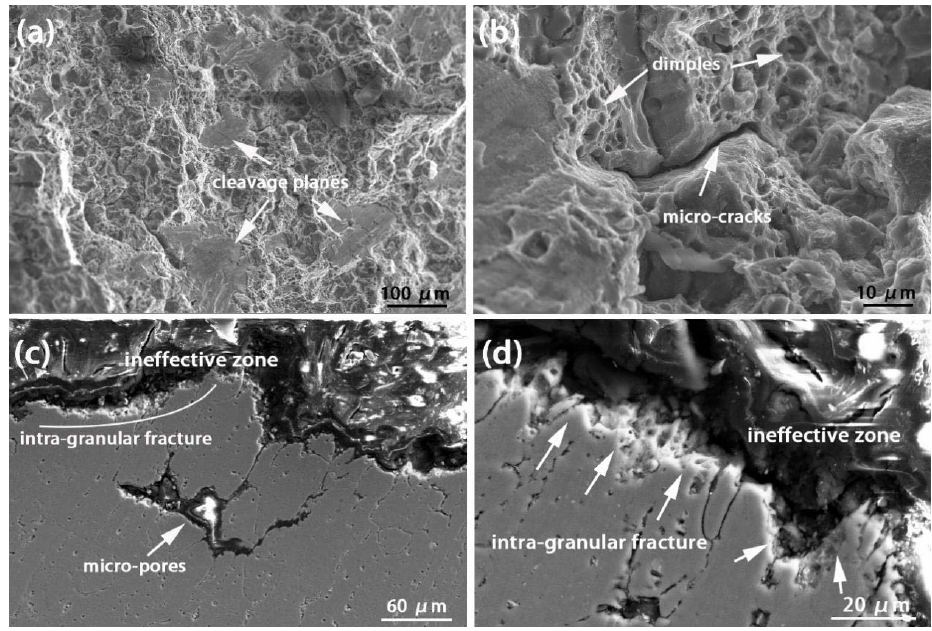
Figure 9. SEM images of the fracture morphology of the RT tensile samples that soaked at 620 °C for 5 min, ( a , b ) fracture surfaces; ( c , d ) fracture profiles.